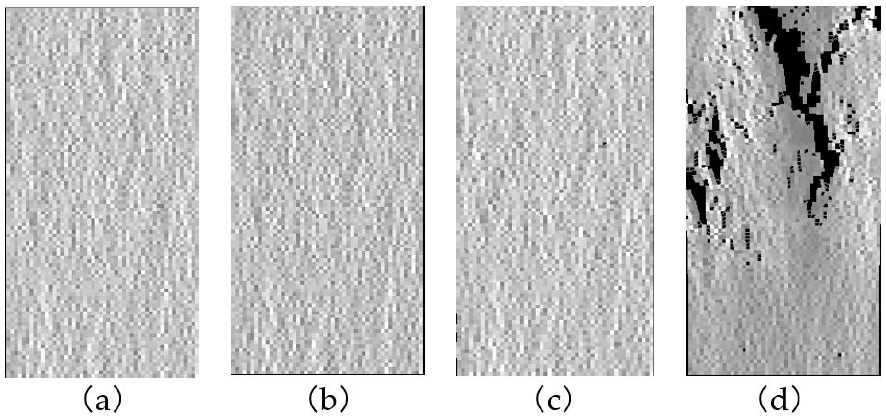
Figure 10. Deformation and rupture of coal samples when the gas pressure is 1 MPa: ( a ) the loading step is 16; ( b ) the loading step is 29; ( c ) the loading step is 41; ( d ) the loading step is 63. (4) Fracture analysis of coal samples when the gas pressure is 1.5 MPa